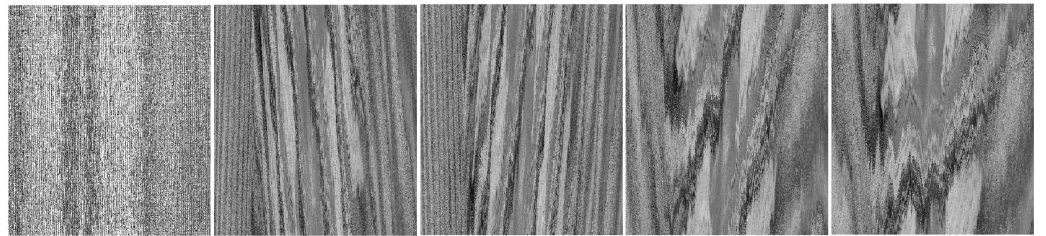
Figure 8. Decrypting Mandrill image with different values of k and n. From left encrypted image, decryption with 𝐿 𝑘 only, decryption with 𝐿 𝑛 only, decryption with k = 12 n = 6 and decryption with k = 12 n = 7.